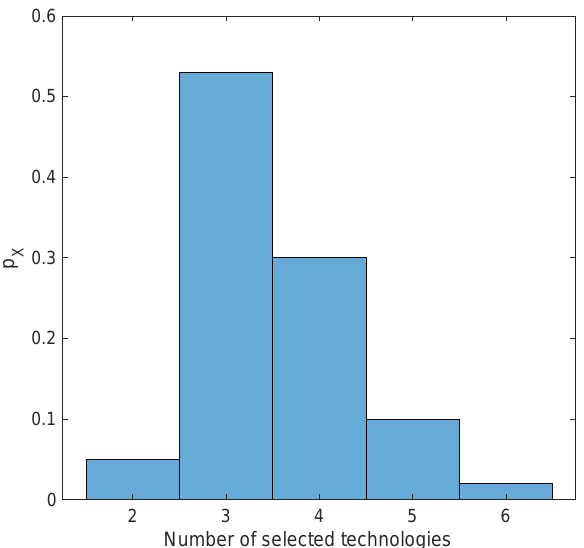
Figure 7. The optimal number of selected technologies as a function of the available technologies for three different values of risk matrices.